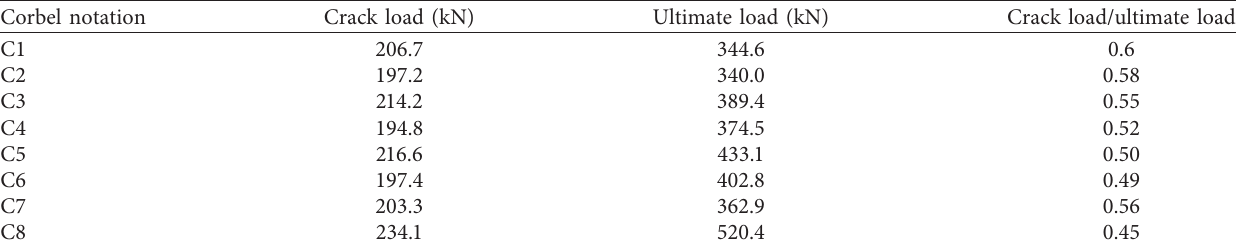
Table 8: Cracking and ultimate loads.